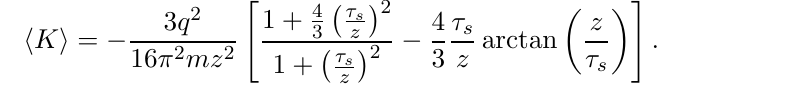
) of the particle in the late time i